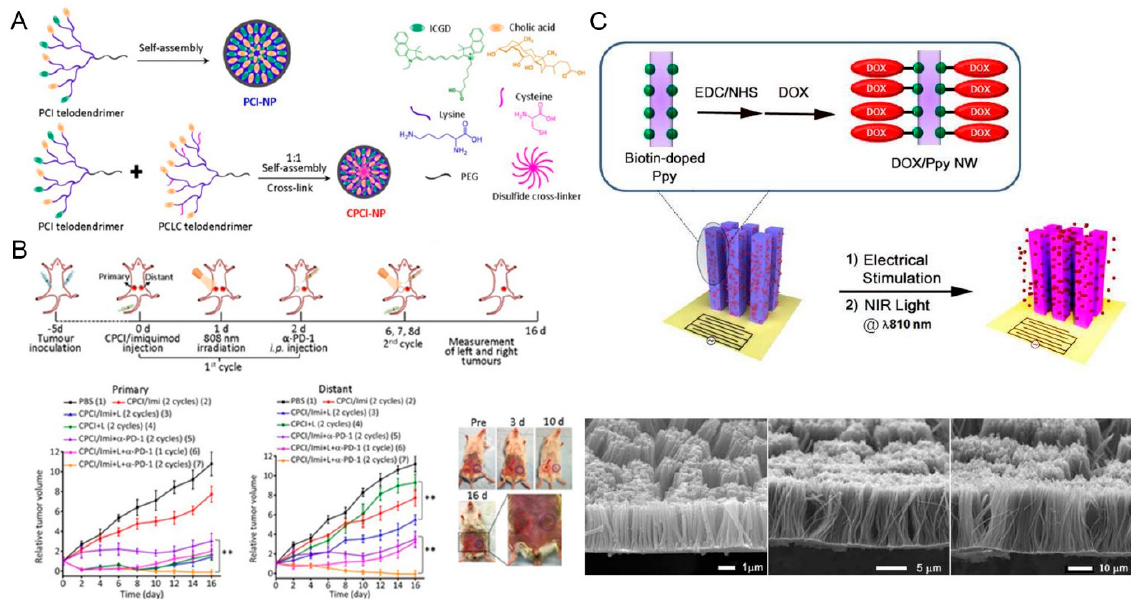
Figure 5. Schematic illustrations of several carbon-based nanomaterials. ( A ) Schematic self-assem- bly illustration of photochemical internalization nanoparticle (PCI − NP) and the coassembled nano- particle (CPCI − NP). ( B ) Synergistic anti-tumor activity of photothermal-/immunotherapy in the mice bearing orthotopic 4T1 breast cancer (both sides). ** p < 0.01 in the line chart on the left by comparing group 5 (CPCI/Imiquimod − NP + α− PD − 1) with group 7 (CPCI/Imiquimod − NP +808 nm laser + α− PD − 1); ** p < 0.01 in the line chart on the right by comparing group 5 (CPCI/Imiquimod − NP + α− PD − 1) with group 7 (CPCI/Imiquimod − NP + 808 nm laser + α− PD − 1) and comparing group 4 (CPCI/Imiquimod − NP) with the group 3 (CPCI/Imiquimod − NP + 808 nm laser). ( C ) Schematic illus- tration of DOX − a tt ached polypyrrole (Ppy) nanowires (DOX/Ppy NWs) and SEM images of the fab- ricated Ppy NW arrays. Adapted with permission from [104,105]. Copyright 2022, American Chem- ical Society. ICGD: indocyanine green derivative; EDC: Ethyl − 3 − (3 − Dimethylaminopropyl); NHS: N − hydroxysuccinimide; α PD − 1: alpha programmed cell death; 1PBS: phosphate-buffered saline. Table 3. A summary of organic nanomaterials for PTT in OSCC. Classification